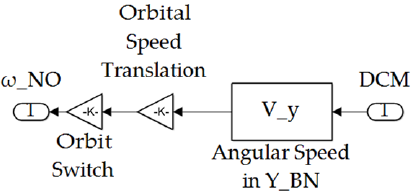
Figure A11. Orbital Frame Calc subsystem depicted in Figure A1.